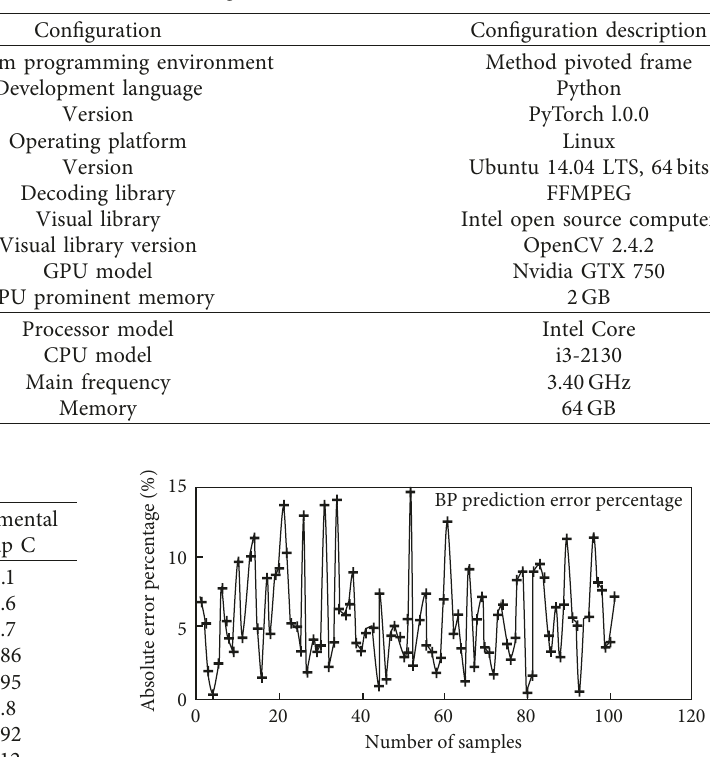
Table 1: Experimental environment configuration table.